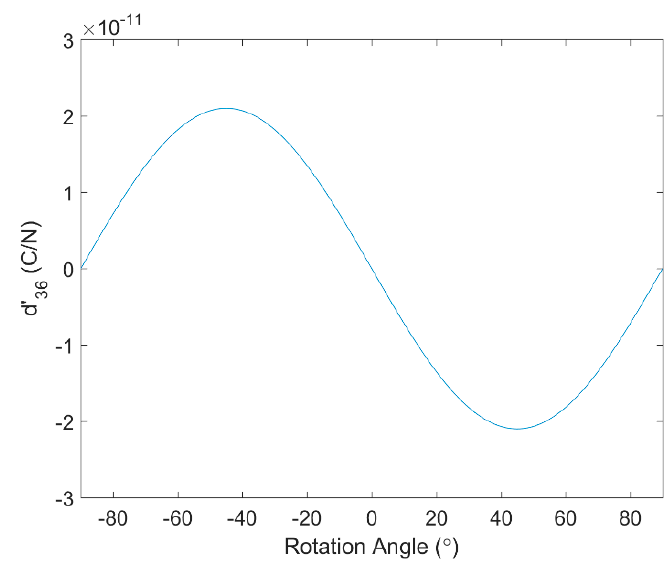
Figure 2. The (cid:2186) (cid:2780)(cid:2783)(cid:4593) coefficient for the rotation angles from − 90° to 90°. Figure 2. The d (cid:48) 36 coefficient for the rotation angles from